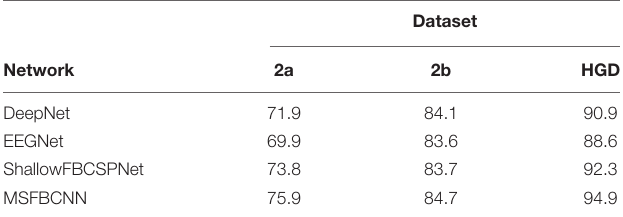
TABLE 3 | Accuracy of inter-subject transfer learning.